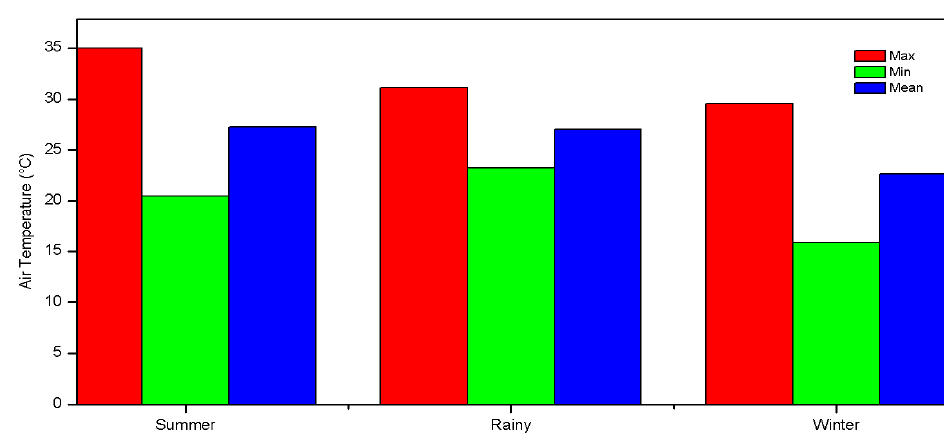
Figure 3. Seasonal temperature (maximum, minimum, and mean) for summer (March ‒ April), rainy season (May ‒ Octo- ber), and winter (November ‒ February) during the period 1971 ‒ 2013 (in